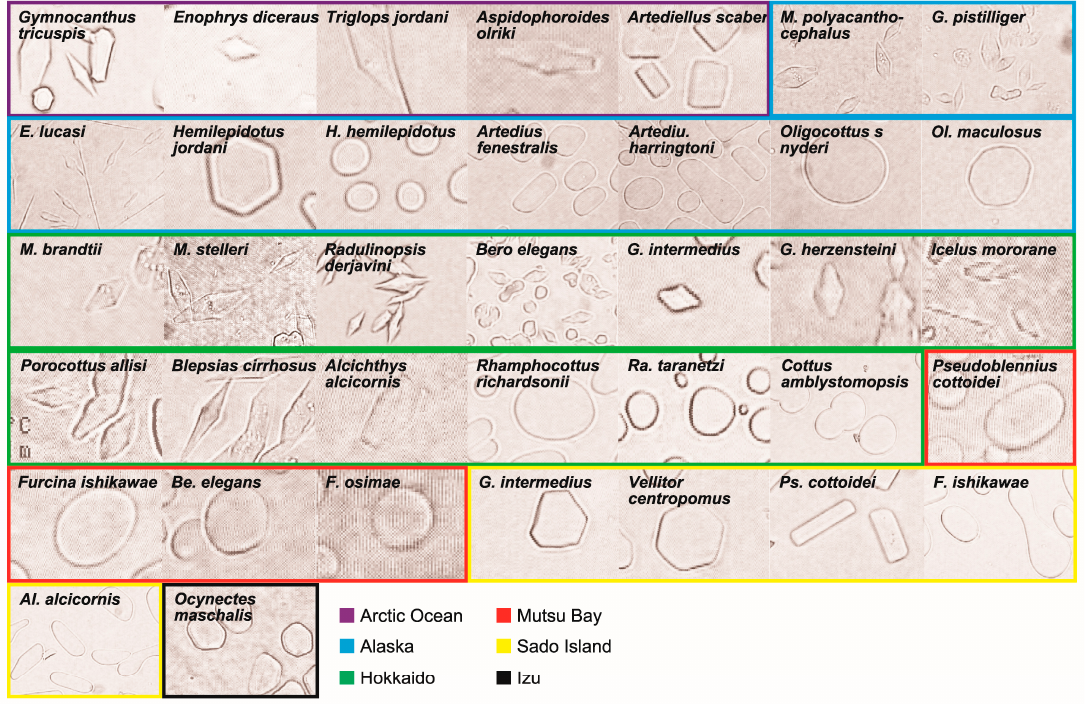
Figure 2. Ice-crystal photos of all species. Bi-pyramidal ice-crystal represents high antifreeze activity, hexagonal ice-crystal represents low antifreeze activity, and other shapes represents inactivity. Solid squares are colored by location; purple, blue, green, red, yellow, and black show the Arctic Ocean, Alaska, Hokkaido, Mutsu Bay, Sado Island, and Izu, respectively.